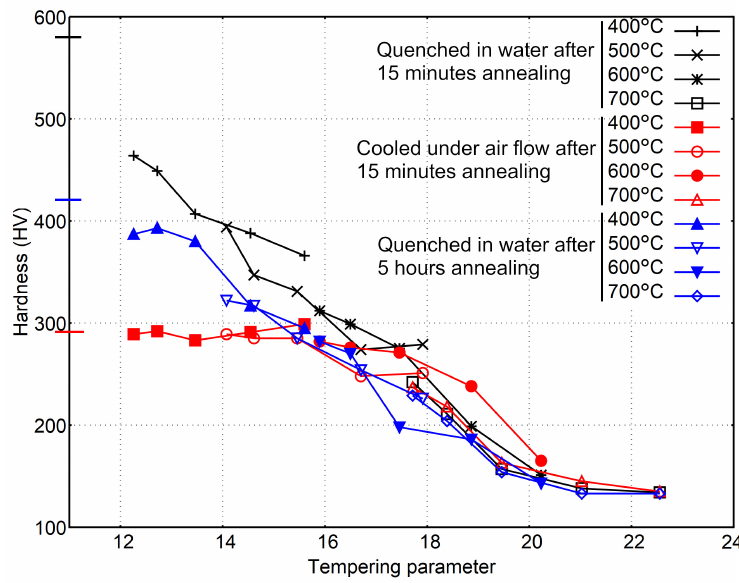
Figure 6. Evolution of hardness with the tempering parameter.